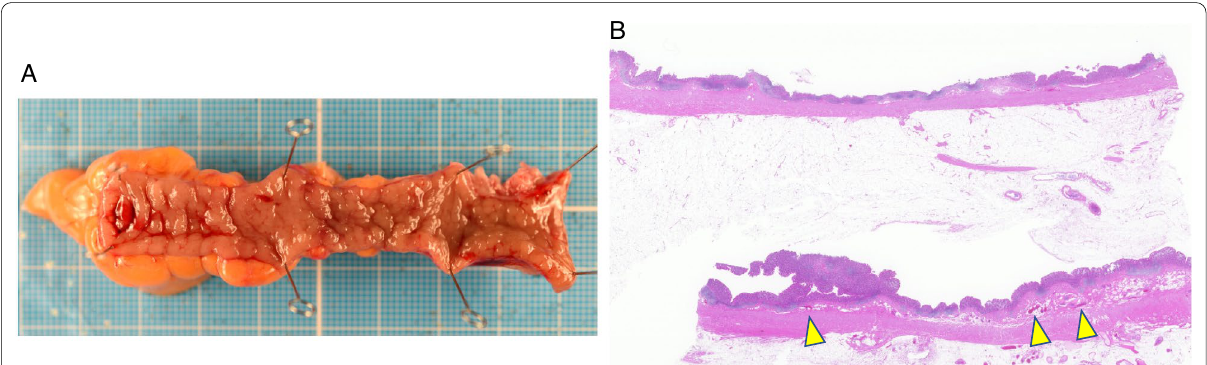
Fig. 2 Excised specimen, histopathological findings. a Appendix is 70 Pathological findings showed a couple of bleeding points into the submucosa (arrow head), but no rupture of the arterial wall or abnormalities on the mucosal surface were